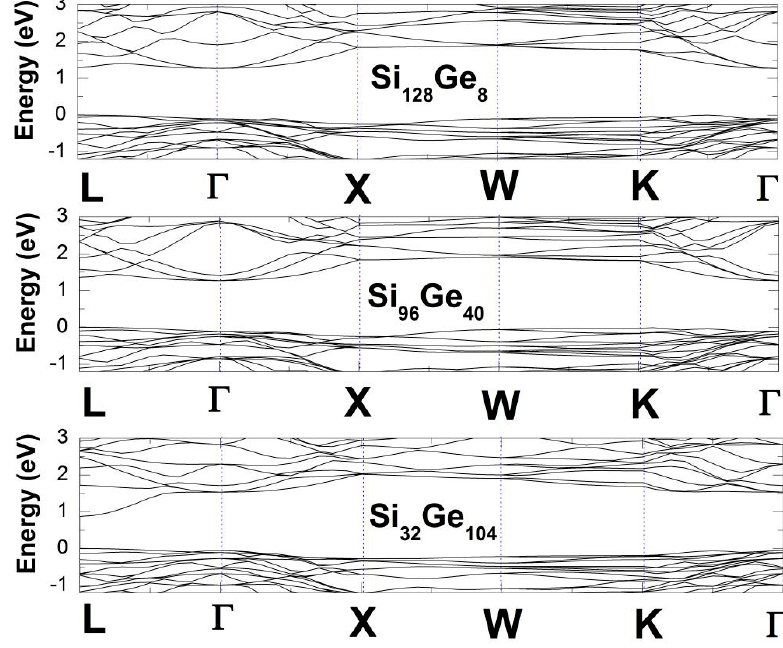
Figure 4. Electronic band structures of Si 136- x Ge x ( x = 8, 40, 104).